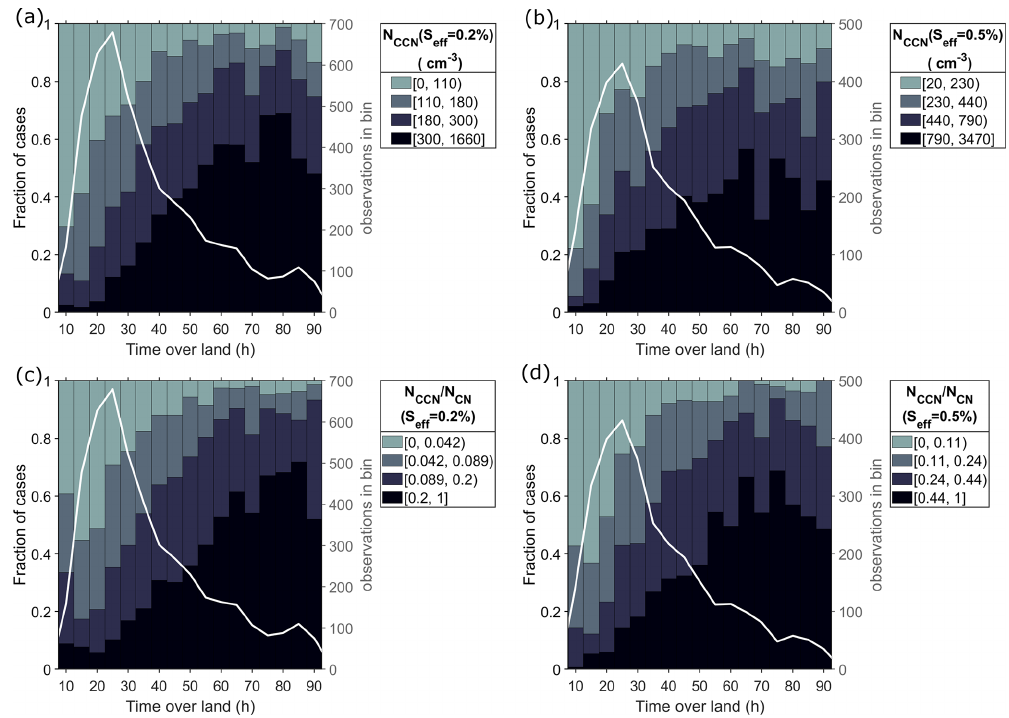
Figure 5. Fractions of the observed (a, b) N CCN and (c, d) N CCN /N CN at (a, c) 0.2% and (b, d) 0.5% supersaturation in four different value ranges, as a function of ToL. The white lines and the right y axes show the number of observations in each bin. The general description of this figure is the same as for Fig. 3. Fourteen and five outliers (MAD > 6) were excluded from panels (a) 1700–3900cm − 3 and (b) 4300– 7200cm − 3 ,